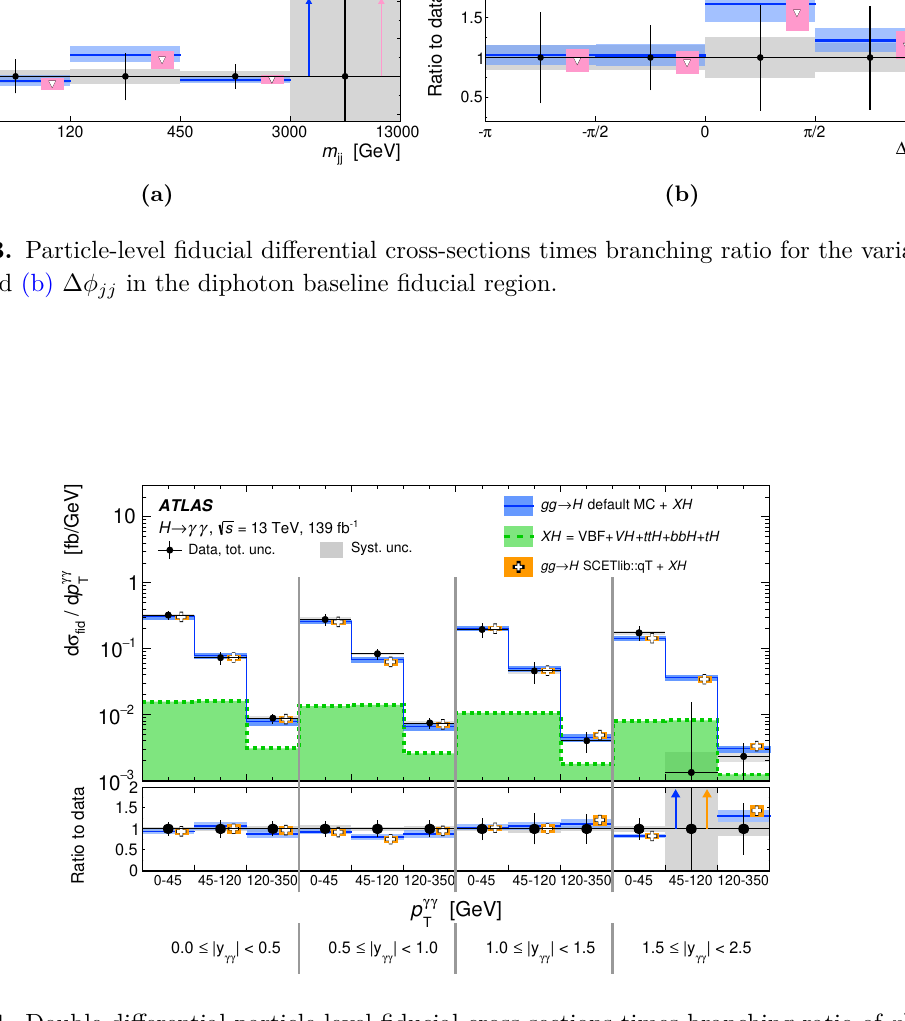
Figure 14. Double-differential particle-level fiducial cross-sections times branching ratio of p γγ bins of | y γγ |